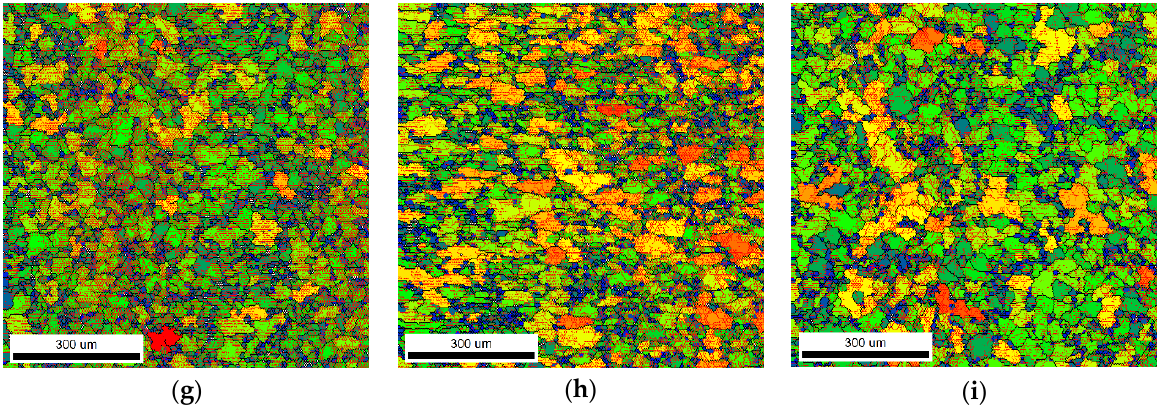
Figure 8. Boundary angle distribution maps after hot compression deformation. (The subgraph